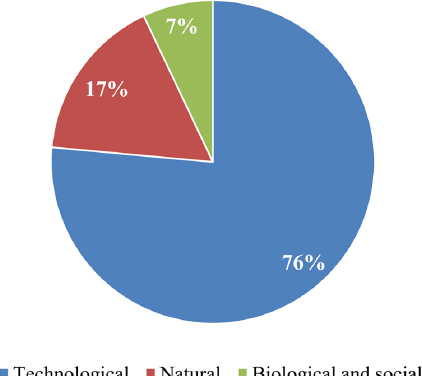
Figure 7. Frequency of different type of emergency. Figure 8. Economic losses due to